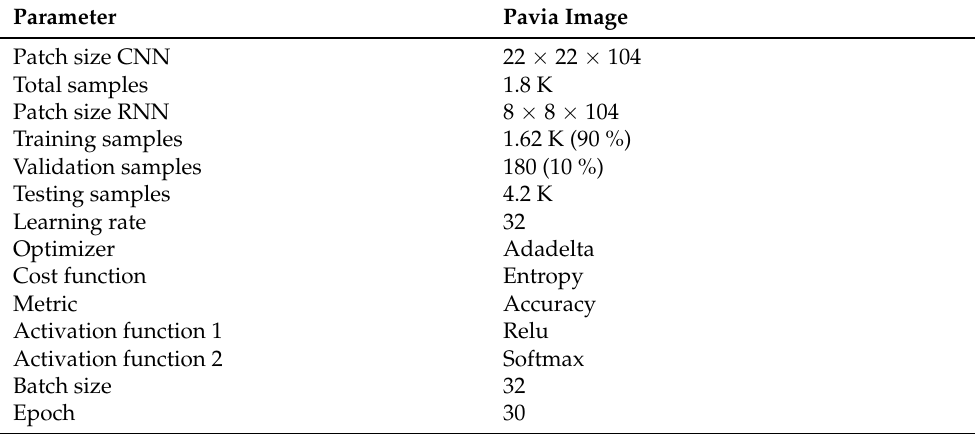
Table 8. Parameter values for experiments applied to Pavia database.